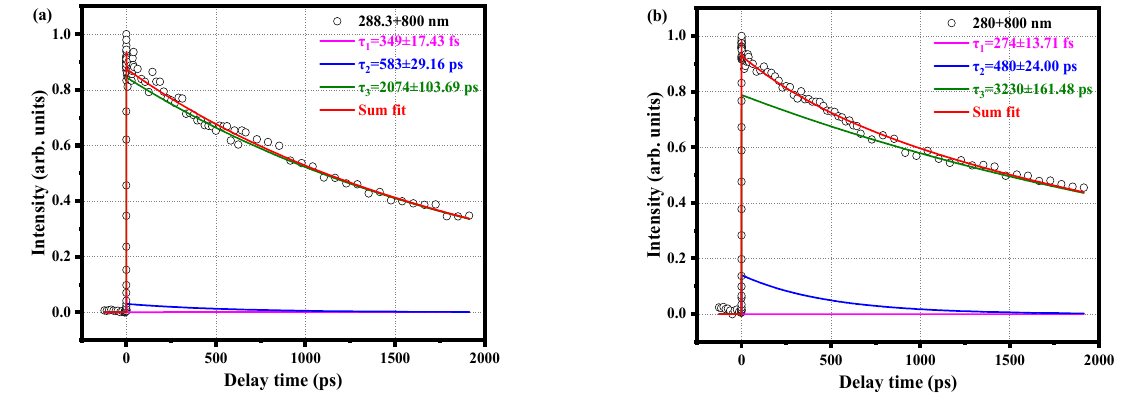
Figure 3. Time decay curves of the parent ion measured with ( a ) a 288.3 nm pump pulse and 800 nm probe pulse, ( b ) a 280 nm pump pulse and 800 nm probe pulse. The circles are experimental data, and the solid lines are fitted data. Both curves are fitted using a Gaussian cross-correlation function and a convolution of three exponential decay functions, resulting in different decay